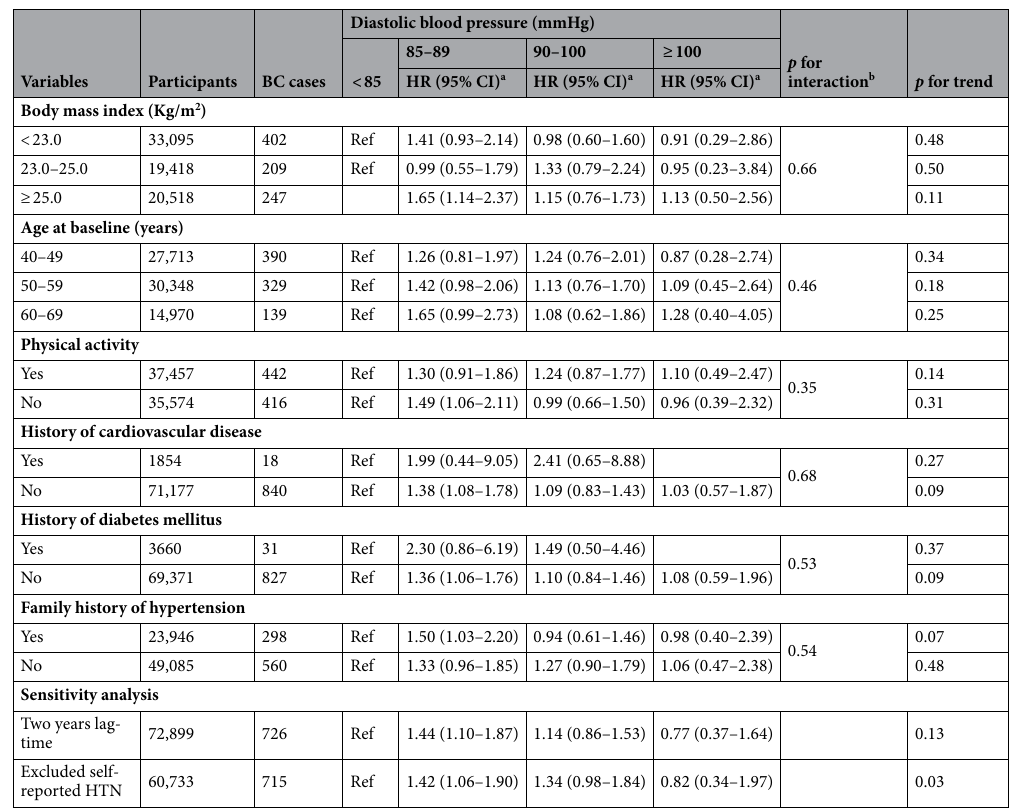
Table 3. Subgroup and sensitivity analysis of breast cancer risk according to diastolic blood pressure categories. HR hazard ratio, CI confidence intervals, HTN hypertension. a Adjusted for family history of breast cancer, parity, age at birth of the first child, age at menarche, breastfeeding, hormone replaced therapy use, physical activity, alcohol consumption, smoking status, self-reported history of hypertension. b Interaction was calculated using Wald test of cross-product